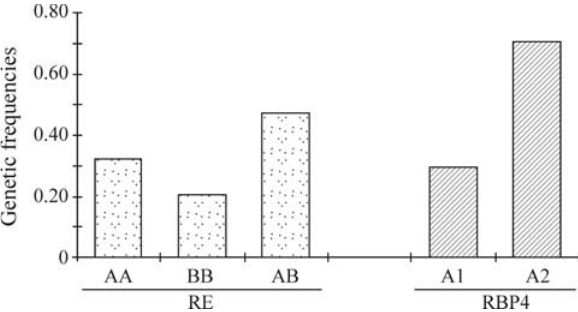
Figure 1 - Genotype frequency of the estrogen receptor and retinol- binding protein 4 gene polymorphisms in sows of a commercial popula- tion from Brazil.